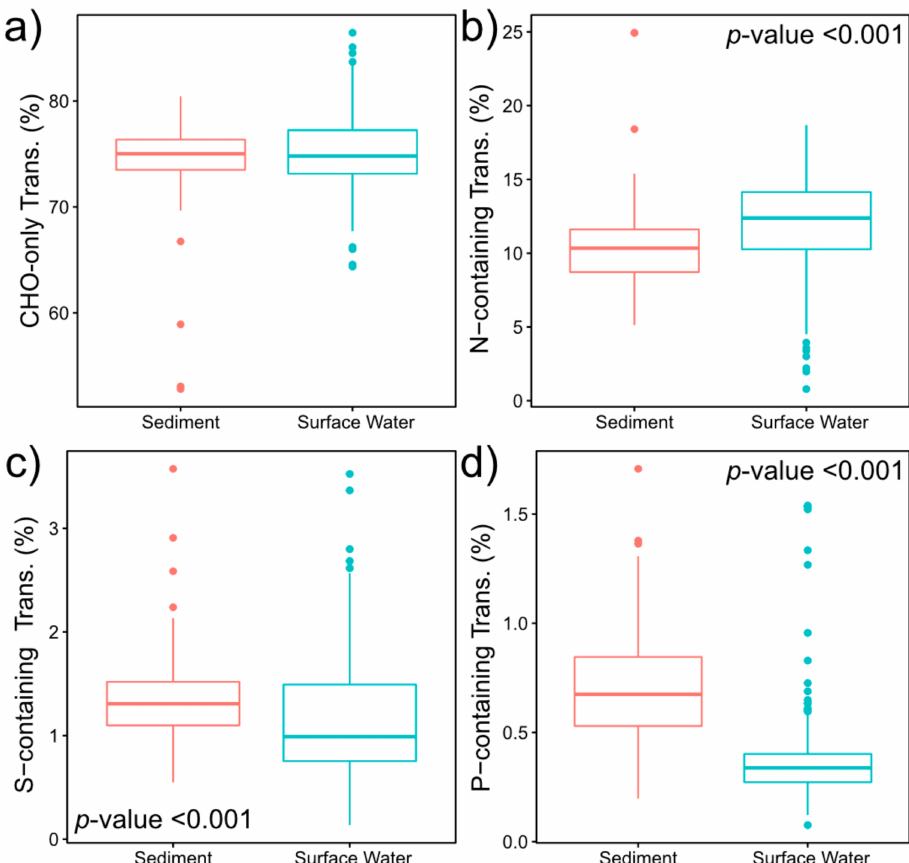
Figure4. Boxplots displaying the patterns of CHO-only transformations ( a ); N-containing transformations ( b ); S-containing transformations ( c ); and P-containing transformations ( d ). False discovery rate (FDR)-corrected two-sided Mann-Whitney U test p -values are provided in either the top right or the bottom left corner of panels with significant